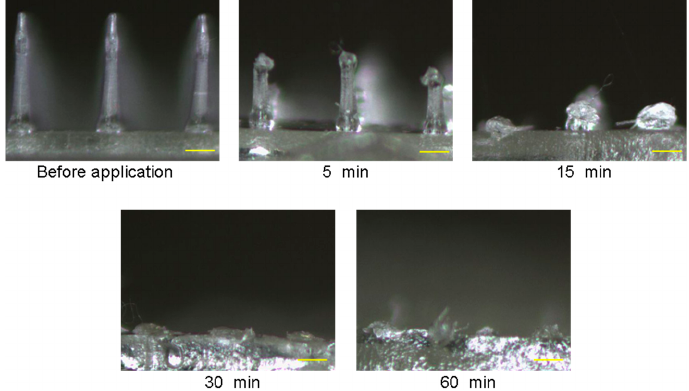
Figure 3. The dissolution process of ALN(TIP)–MN after the application to rat skin. Scale bar: 200 µm.